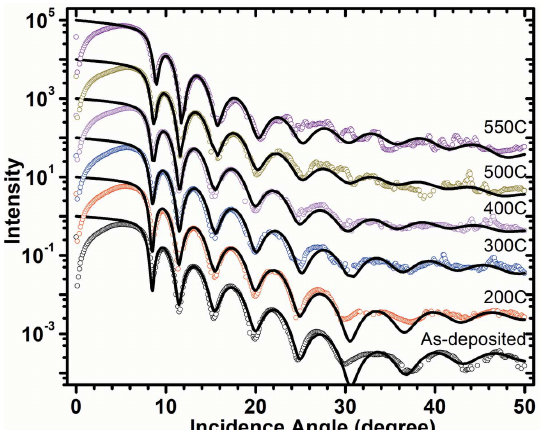
Figure 3 Measured (open circles) and fitted (continuous line) soft X-ray reflectivity curves of as-deposited and annealed samples using 155 eV incident photon energy (80 A˚ ).